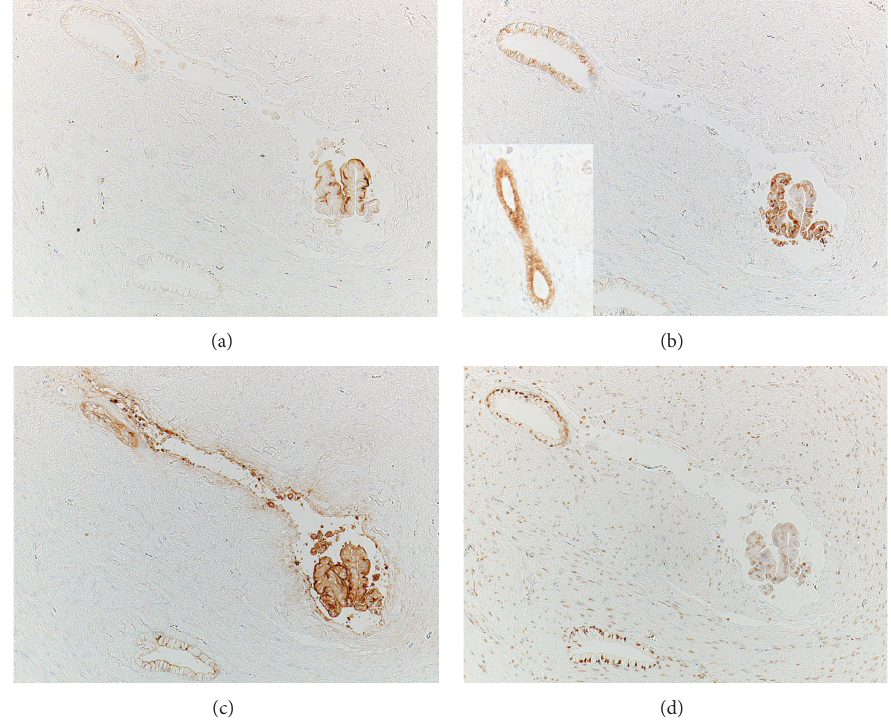
Figure 2: Immunohistochemical features of polypoid adenomyoma of endocervical type using consecutive sections ((a) MUC1, (b) MUC5AC, inset: MUC6, (c) CEA, and (d) ER). The mucin-producing columnar cells express MUC1 (a), MUC5AC (b), and CEA (c). ER is positive in the nuclei of both glandular cells and smooth muscle cells (d). MUC6 reactivity is detected in small glands in other microscopic fields